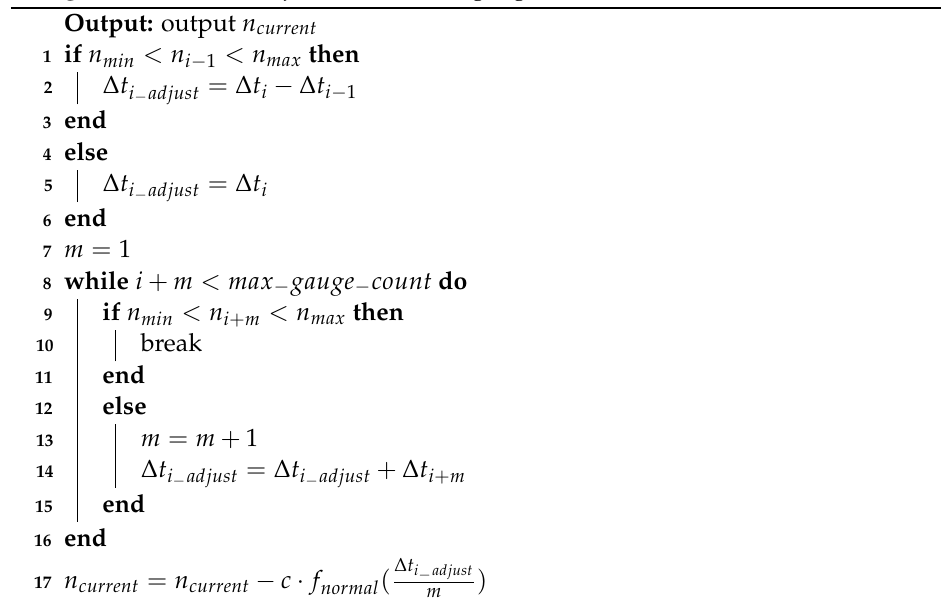
Figure 7. Relationship between the time error and Manning coefficient correction values for differ- ent parameters. Algorithm 1: ∆ t for adjustment of each